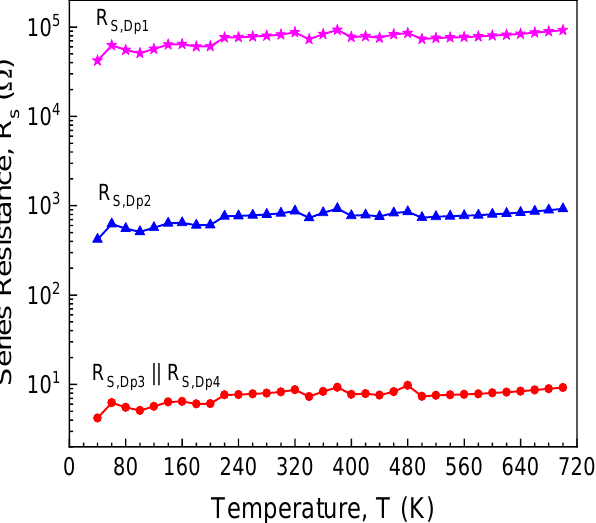
Figure 5. Parallel diode area percentages in respect to total Schottky contact area. Our model entails the evaluation of series resistance contributions [40]. Accordingly, the variations with temperature for the parallel diodes’ series resistances are illustrated in Figure 6. Because Dp3 and Dp4 have comparable current contributions at all tempera- tures, their individual series resistances could not be deconvoluted. Their combined ohmic behavior was determined, at each temperature, with Cheung’s method [54]. R S val- ues for Dp1 and Dp2 were adjusted to account for area differences, while keeping the same variation trend as R S,Dp3 || R S,Dp4 .